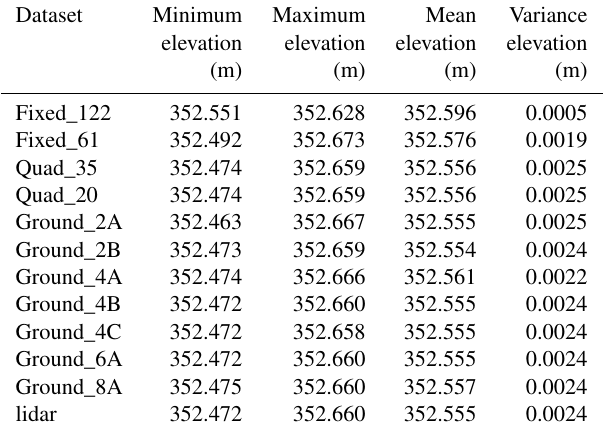
Table 5. Simple statistics of comparative cross-sectional elevations generated using different surveying methods. Values were calcu- lated for nine cross sections individually and then averaged.